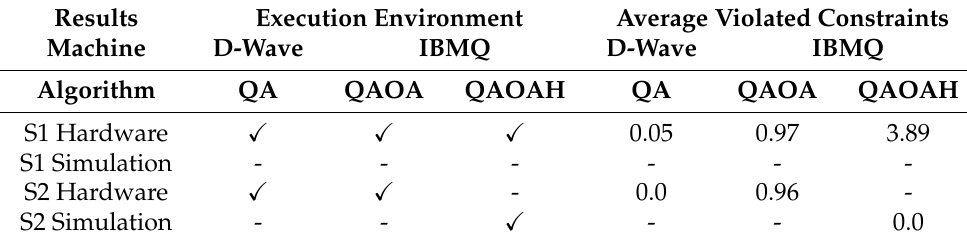
Table 1. S1 and S2 stands for Scenario 1 and 2, respectively. MCO implementations in hardware and simulation execution environment. And number of constraints violated in the various cases.